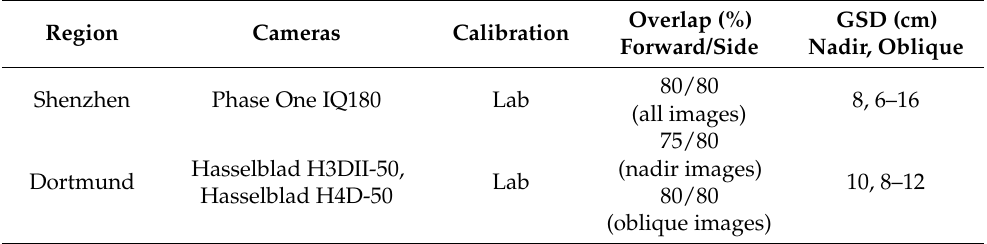
Table 2. Detailed information of the experimental point